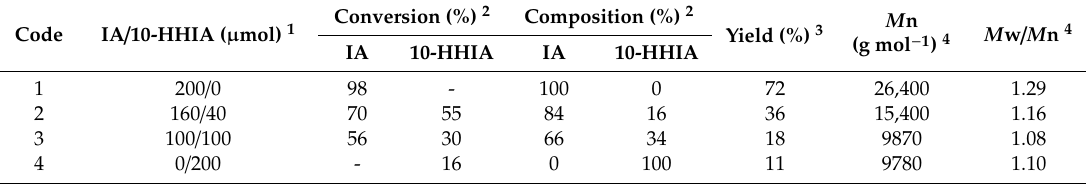
Table 1. Synthesis of poly(IA- co -10-HHIA)s with di ff erent monomer feed ratios.